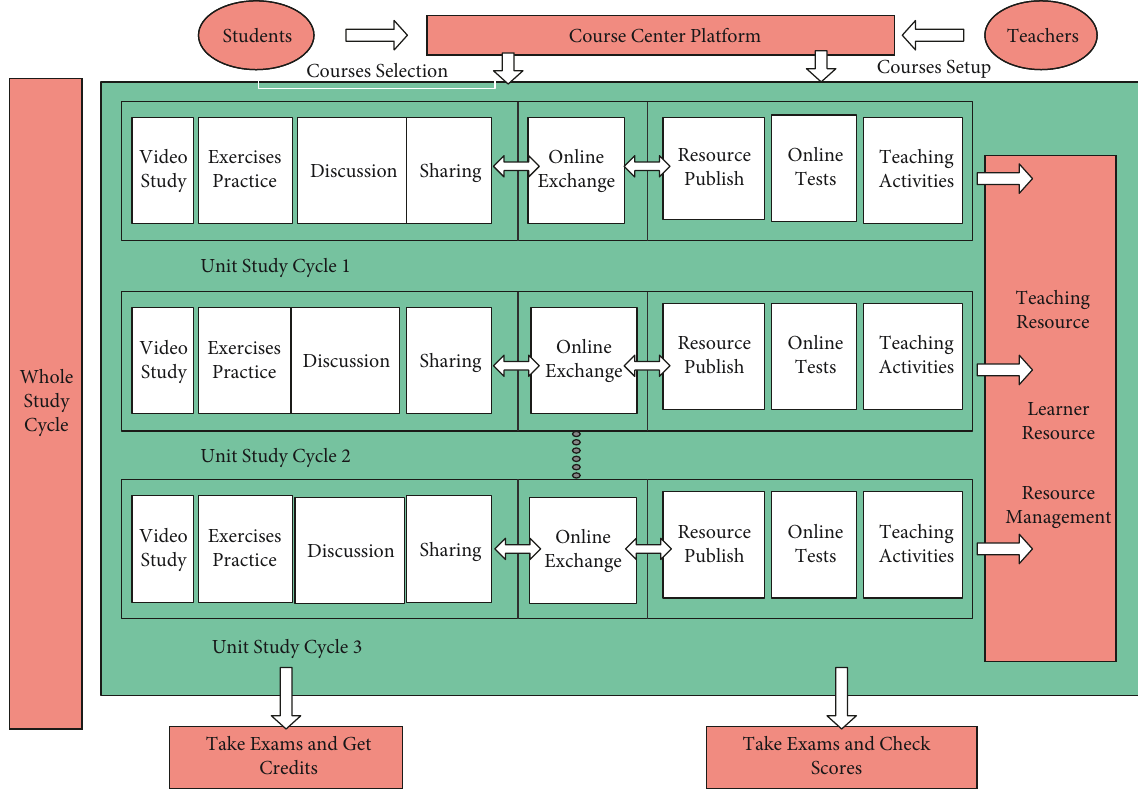
Figure 2: System operation mode diagram in a complete cycle.